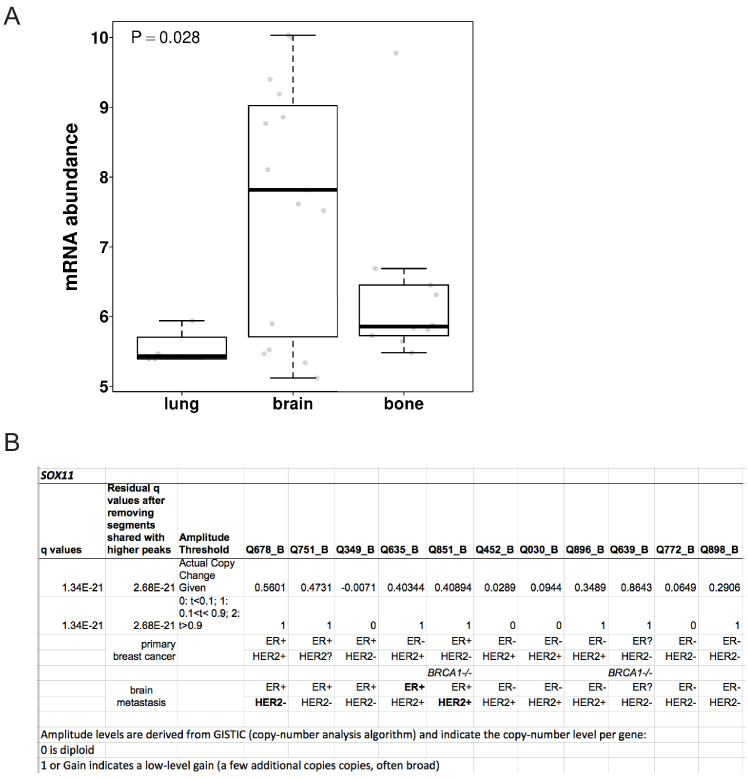
SOX11expression in breast cancer metastasis.(A) SOX11 expression in breast cancer metastasis (Zhang cohort: GSE140200). (B) SOX11 is amplified and highly expressed in ~30% breast cancer brain metastasis (BCBM) from ER-, ER+, HER2+ and BRCA1-/- breast cancer patients in a study by Saunus et al., 2015.